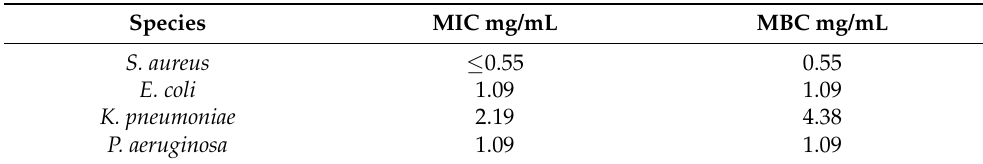
Table 6. Testing of GS-2 with thymol using CLSI M26-A guidelines for 24 h of exposure; n = 6. Concentrations represent concentration of capric acid in GS-2.